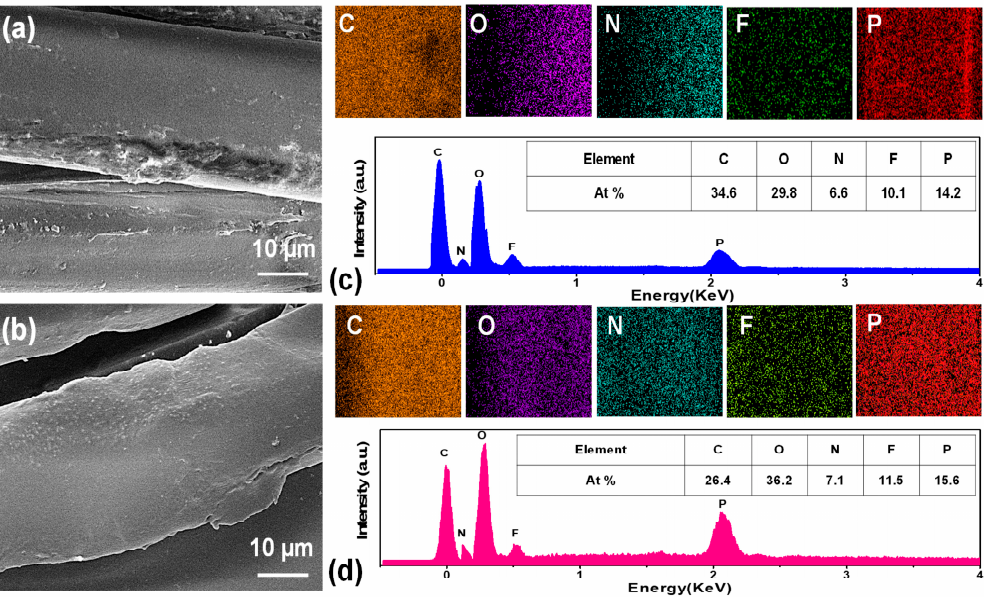
Figure 2. The SEM and Energy-Dispersive Spectrometer (EDS) element mapping with their atomic ratio (At) table (inset) of aramid fabric after coating ( a , c ) for UC and ( b , d ) for PC, respectively.